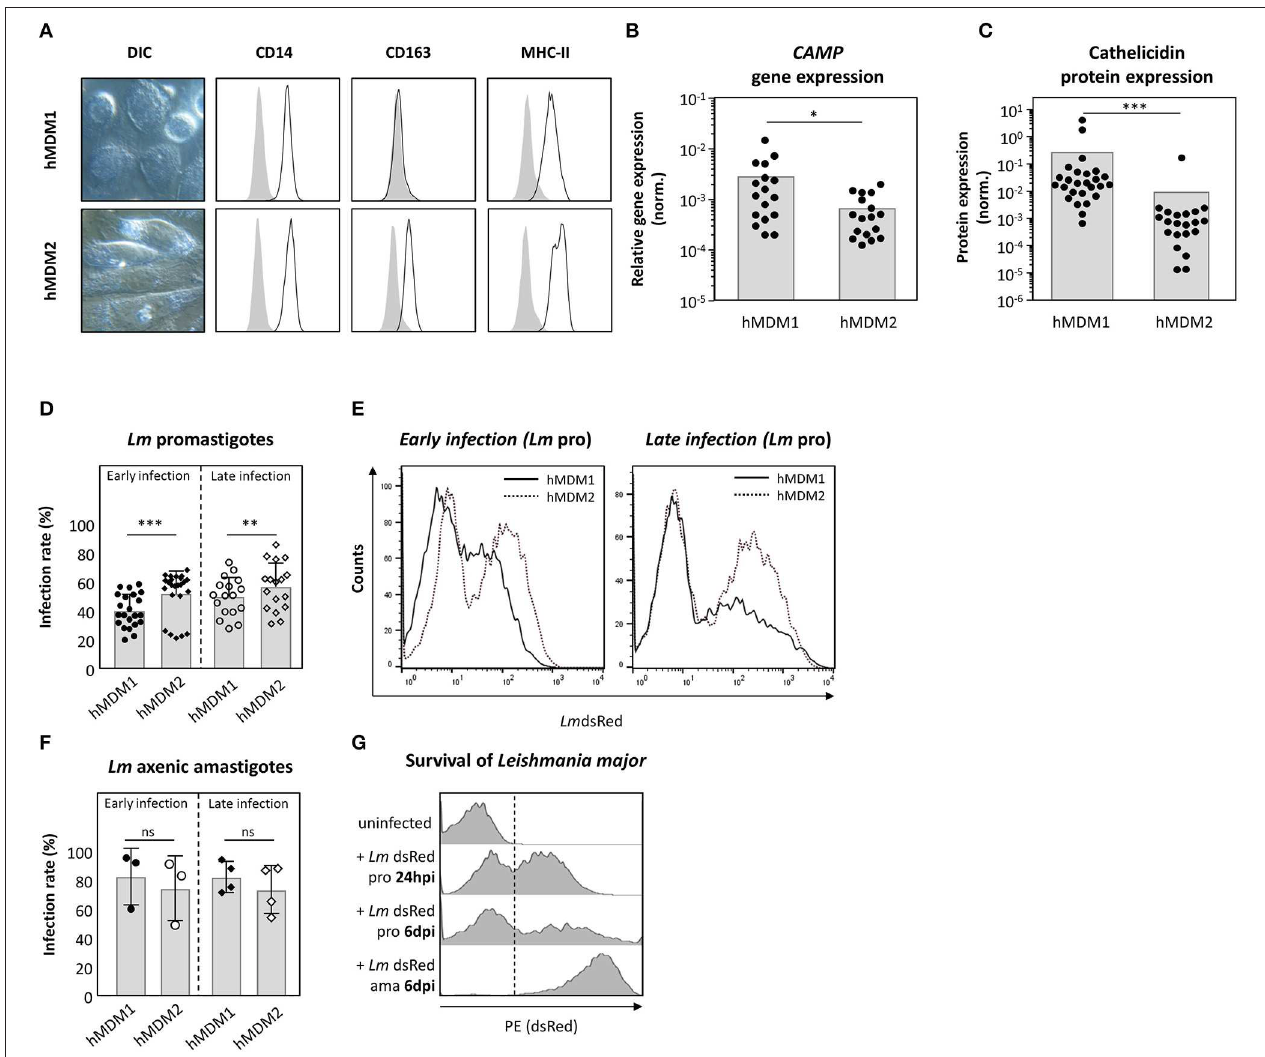
FIGURE 3 | Expression of cathelicidin is more prominent in pro-inflammatory hMDM1 then in anti-inflammatory hMDM2. (A) Live cell imaging DIC micrographs of inflammatory hMDM1 and anti-inflammatory hMDM2, characterized by flow cytometry for CD14, CD163, and MHC-II surface expression (black line) in line with the isotype controls (gray). (B,C) CAMP gene expression ( n = 17) (B) and cathelicidin protein expression ( n = 21) (C) were assessed in hMDM1 and hMDM2 by qRT-PCR and western blot. CAMP expression was normalized against the house keeping gene GAPHD . Western blots were analyzed by densitometry (ImageJ analysis), normalizing cathelicidin against ß-actin protein expression. (D–F) Both hMDM1 and hMDM2 were infected with either transgenic Lm pro ( n = 22–24) (D,E) or ama ( n = 3–4) (F) (MOI of 10). After 3h, extracellular parasites were removed by washing following incubation at 37 ◦ C, 5% CO 2 . After 24–48 hpi (early infection) or 6–7 dpi (late infection) infection rate was assessed by flow cytometry. (G) Lm dsRed pro transform into ama over time, indicated by an increased fluorescent intensity. Micrographs, histograms and data, presented as mean ± SD, are representative for at least 3 independent experiments (Wilcoxon matched-pairs signed rank test; * p < 0.05; ** p < 0.01; *** p < 0.001; ns, not significant; pro, promastigotes; ama,